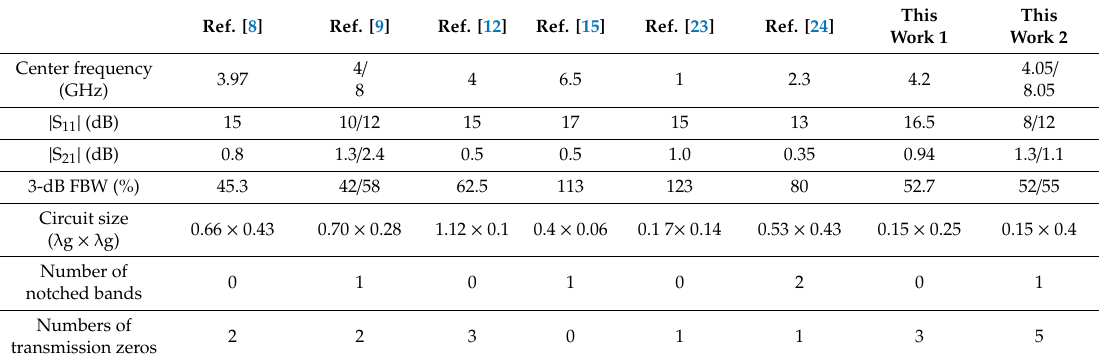
Table 1. Comparison of filter performances from this work with the previous published